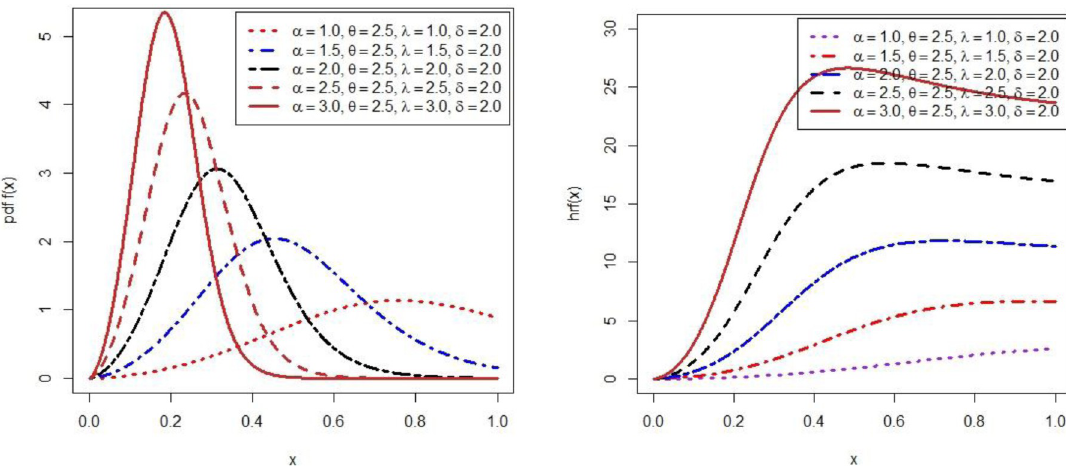
Fig 1. Probability density function (left panel), hazard rate function (right panel) with different parameter’s value.